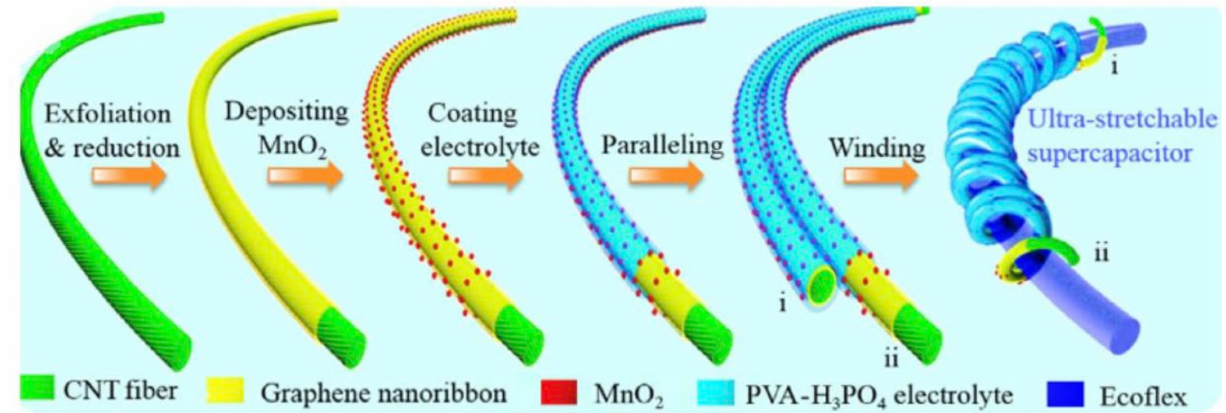
Figure 15. Schematic illustration showing the fabrication of an ultra-stretchable wire-shaped superca- pacitor